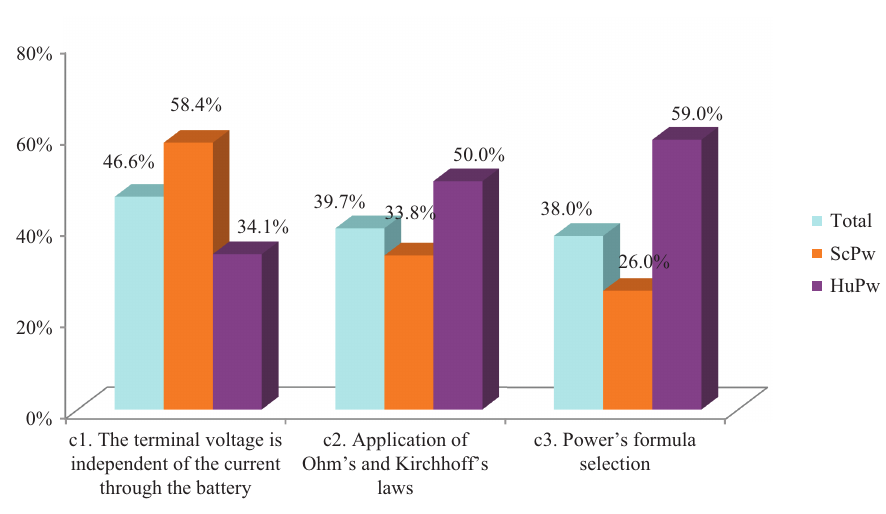
Fig. 5. Τhe percentage appearance of the incorrect